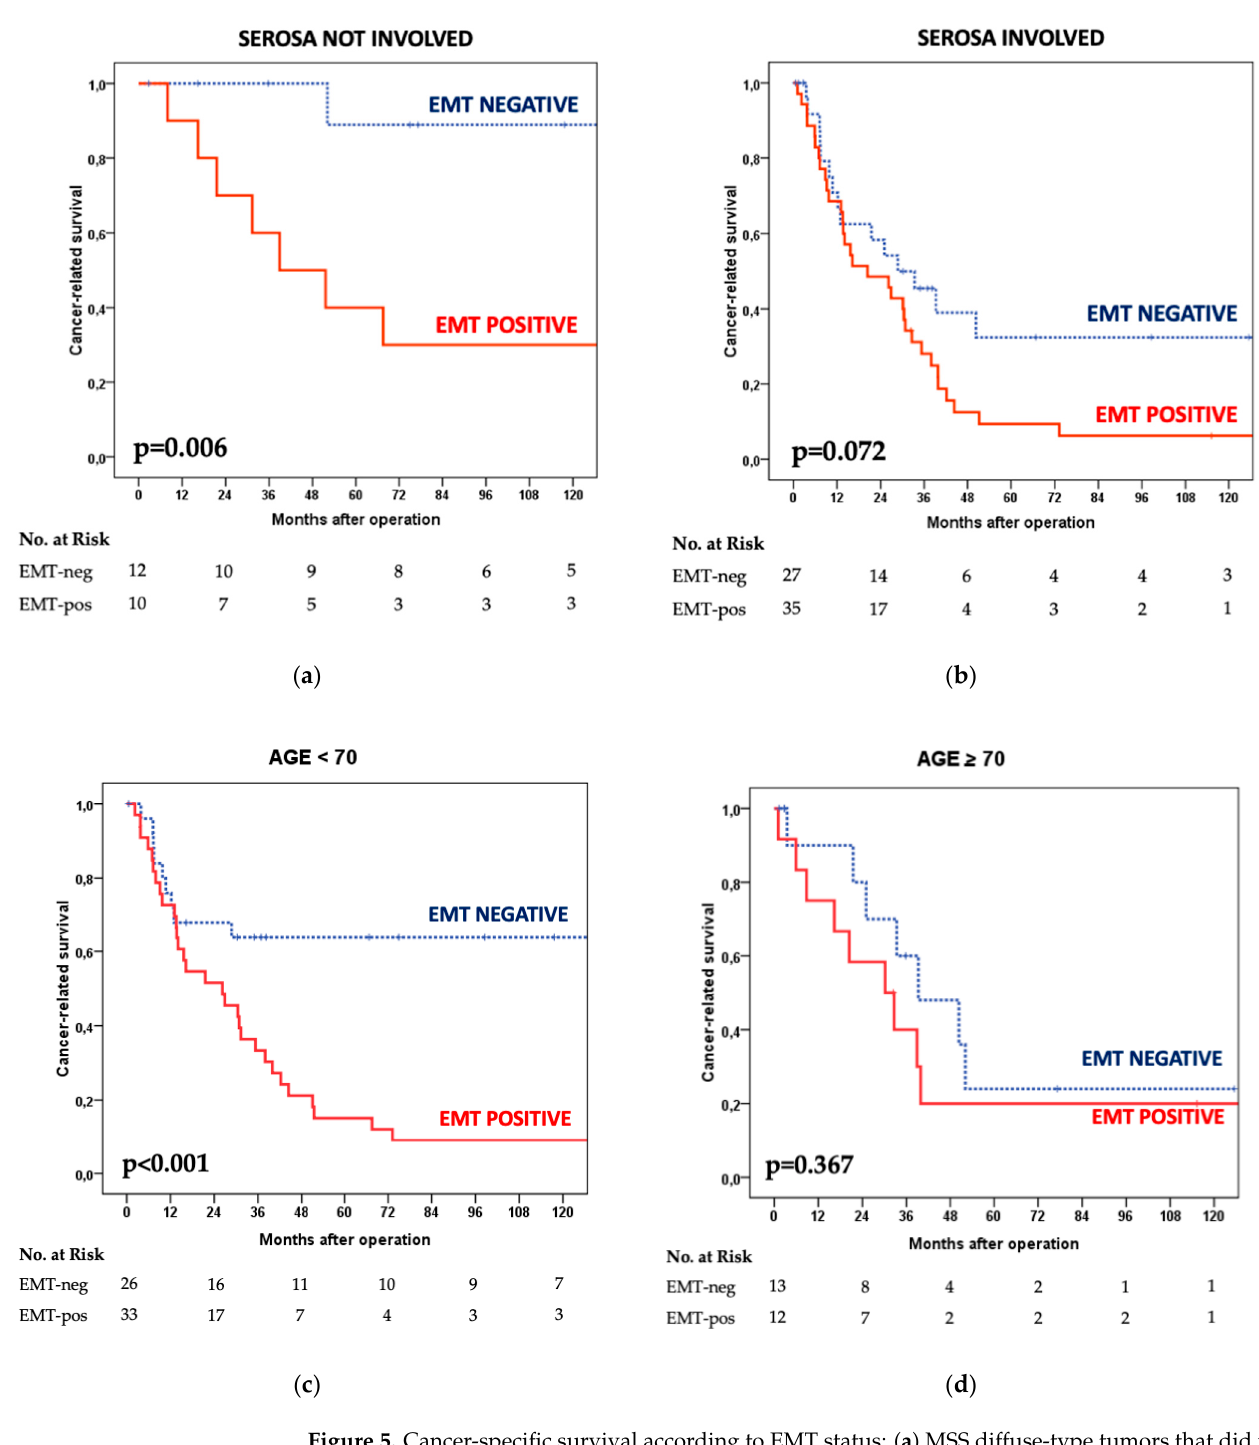
Table 3. Tumor recurrence after surgery according to EMT status.